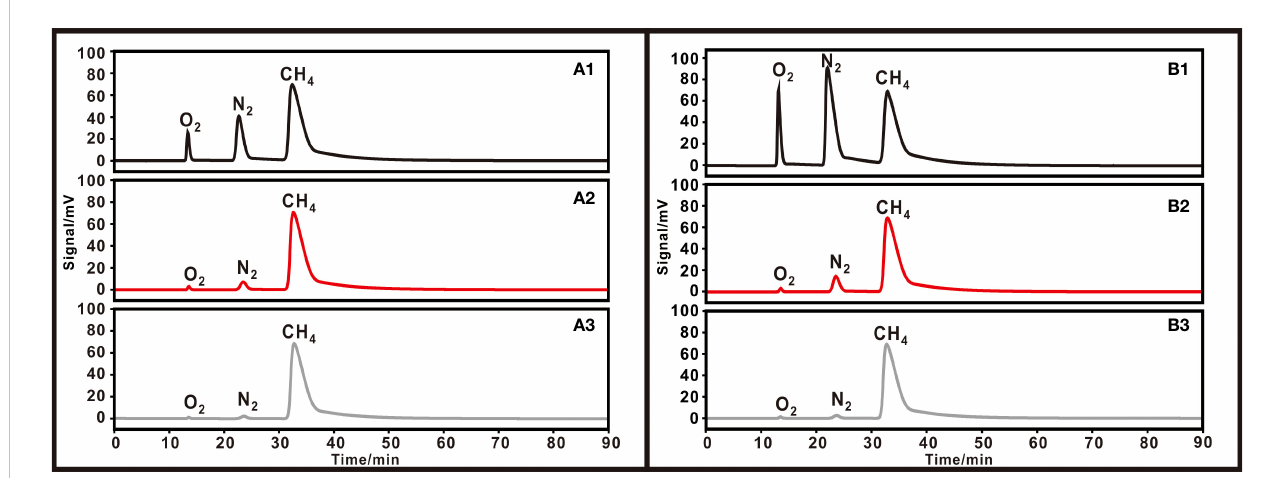
FIGURE 9 Chromatograms of gases with different air contents. (A) 75% methane + 25% air for (1) initial gas (2) single, and (3) double puri fi cation. (B) 50% methane + 50% air for (1) initial gas (2) single, and (3) double puri fi